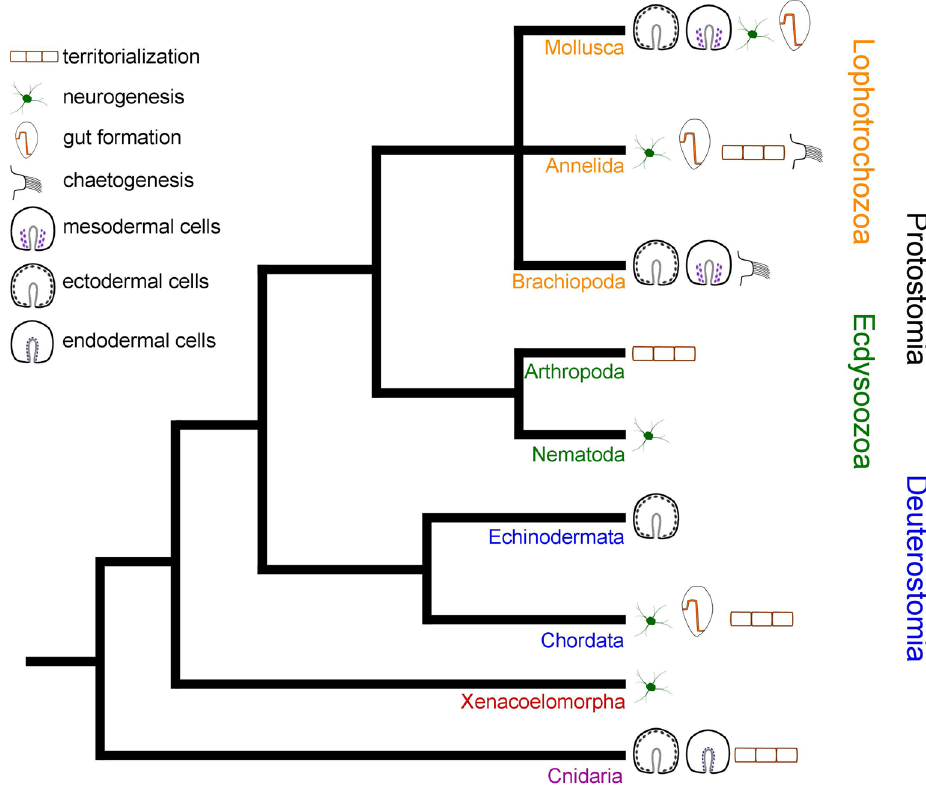
Figure 6. HES gene expression in metazoan organogenesis. Lophotrochozoa: Mollusca: Expression is in ectodermal cells of pre-larval stages and subsequently during mesoderm formation as well as in neurogenesis and development of the digestive tract. Annelida: Expression is during formation of the digestive tract, neurogenesis, segmentation, and chaetogenesis. Brachiopoda: Expression is in the ectoderm of pre-larval stages, during early mesoderm formation, and in chaetogenesis. Ecdysozoa: Hexapoda: Expression is during segment formation. Nematoda: Expression is during neurogenesis. Deuterostomia: Echinodermata: Expression is in the larval ectoderm. In the late pluteus larva, HES expression is in the region of the apical organ. Chordata: Expression is during neurogenesis, somitogenesis, and in the digestive tract. Xenacoelomorpha: Expression is during neurogenesis. Cnidaria: Expression is in the ectoderm and endoderm of early developmental stages and during budding in hydrozoans. Data from previous investigations 19,21,35–38,81–85 and present study. Expression pattern schemes were designed with Inkscape (version 0.92.4; https:// inksc ape. org) and Gimp 2 (Version 2.8.22; https:// www. gimp.